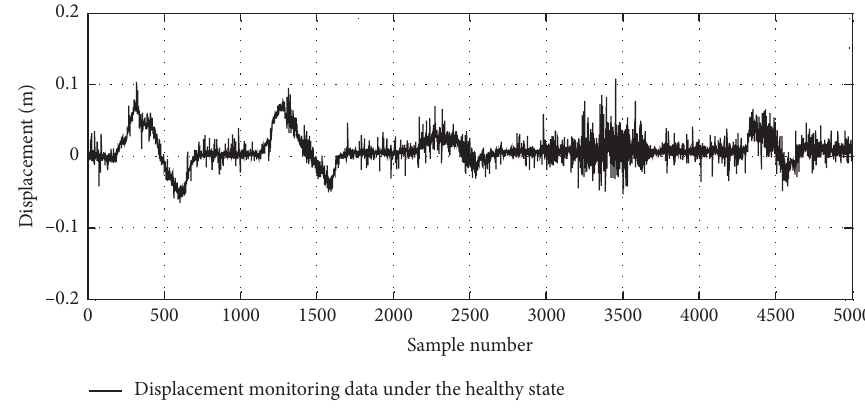
Figure 6: Displacement monitoring data of towers A and B. (a) The NS deformation of tower A. (b) The EW deformation of tower A. (c) The NS deformation of tower B. (d) The EW deformation of tower